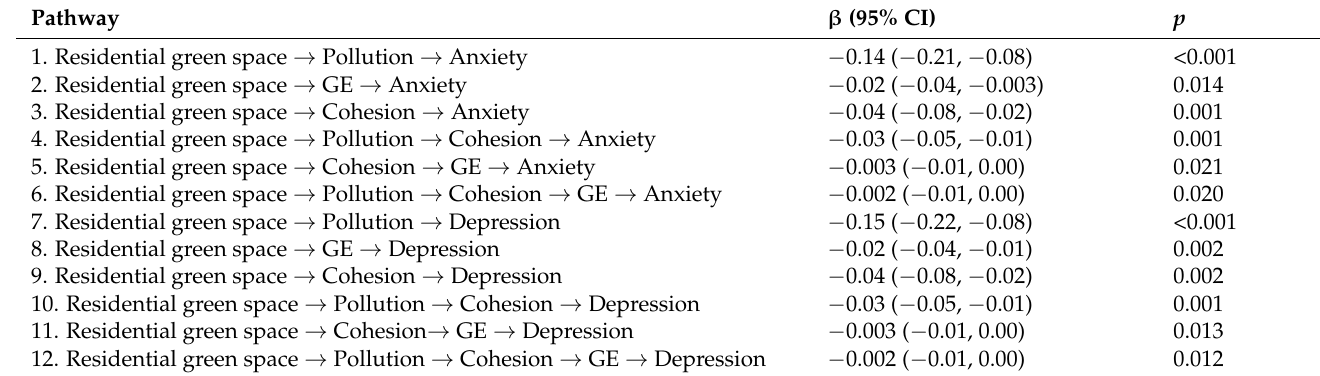
Table 4. Standardized indirect pathways from perceived residential green space to mental